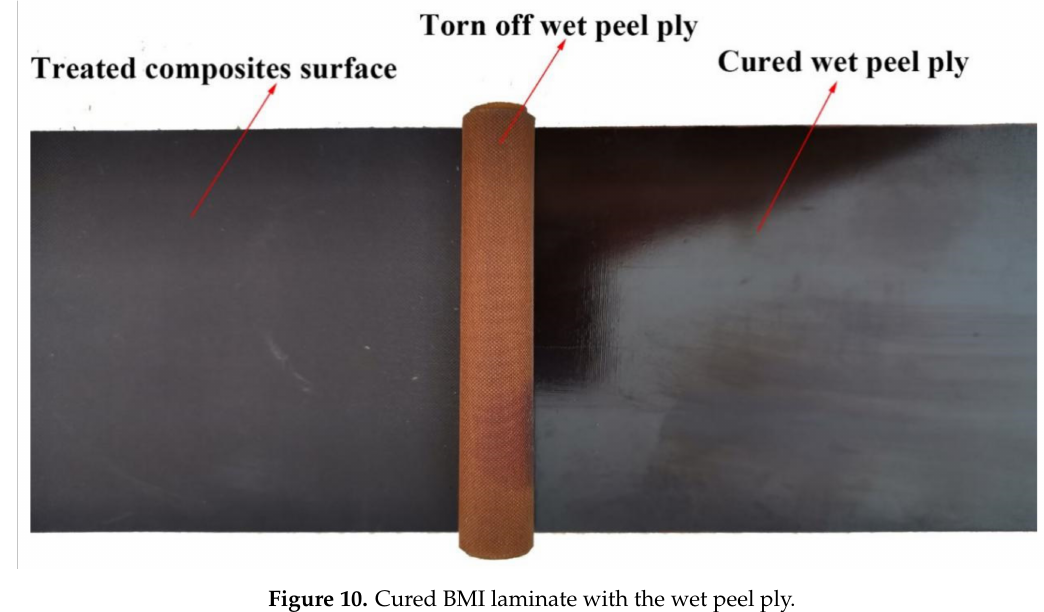
Figure 10. Cured BMI laminate with the wet peel ply.